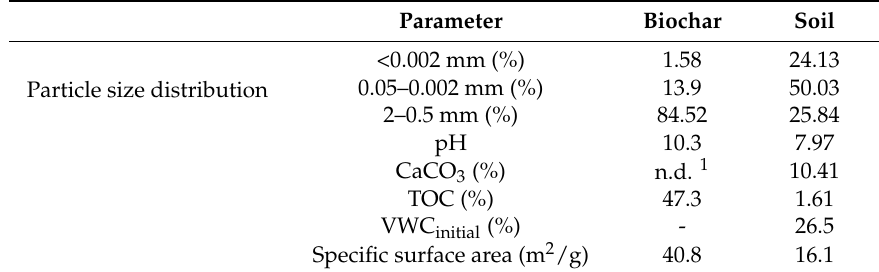
Table 1. Physical and chemical characteristics of the soil and biochar used in the experiment.